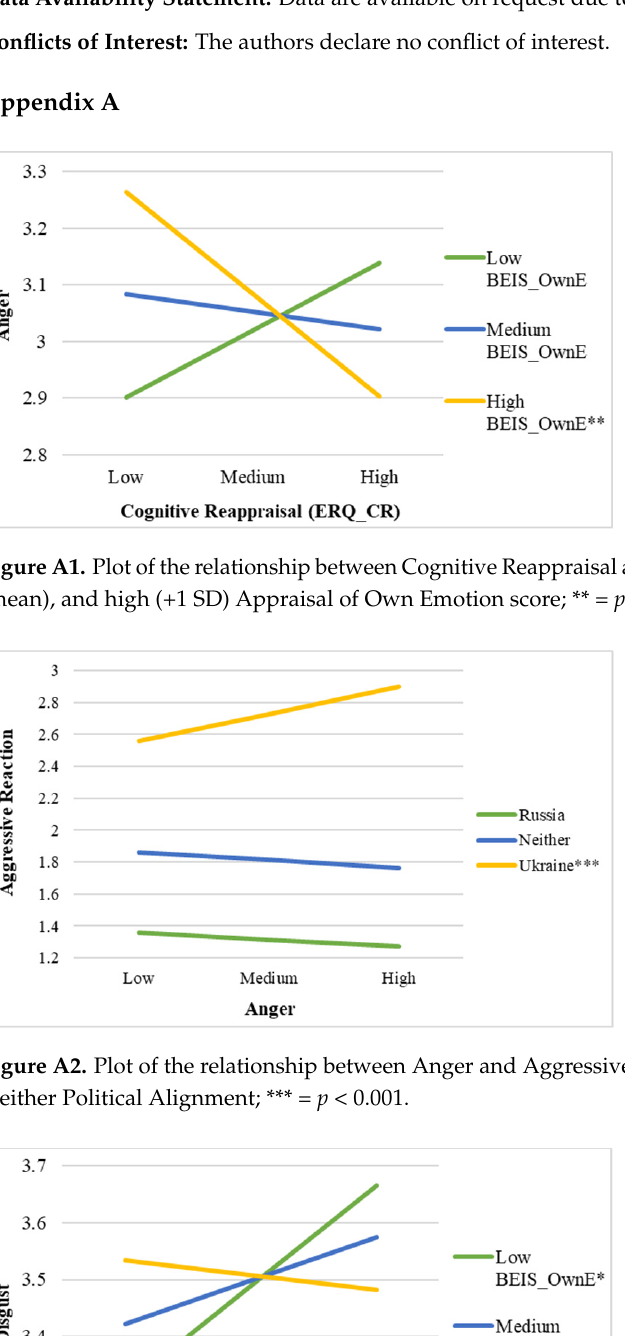
Figure A4. Plot of the relationship between Disgust and Aggressive Reaction on Russia, Ukraine, and Neither Political Alignment; ** = p < 0.01.